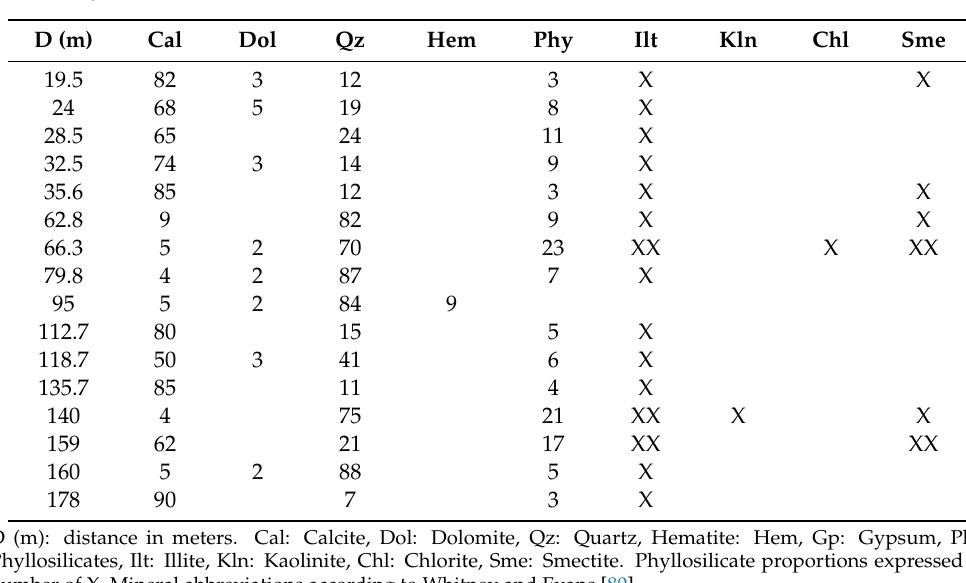
Table 6. XRD analysis of the samples from Tablate A locality in the southeastern edge of the Granada Basin. The distance corresponds to the distance from fault, which is also plotted on the x-axes of the plots in Figure 13.